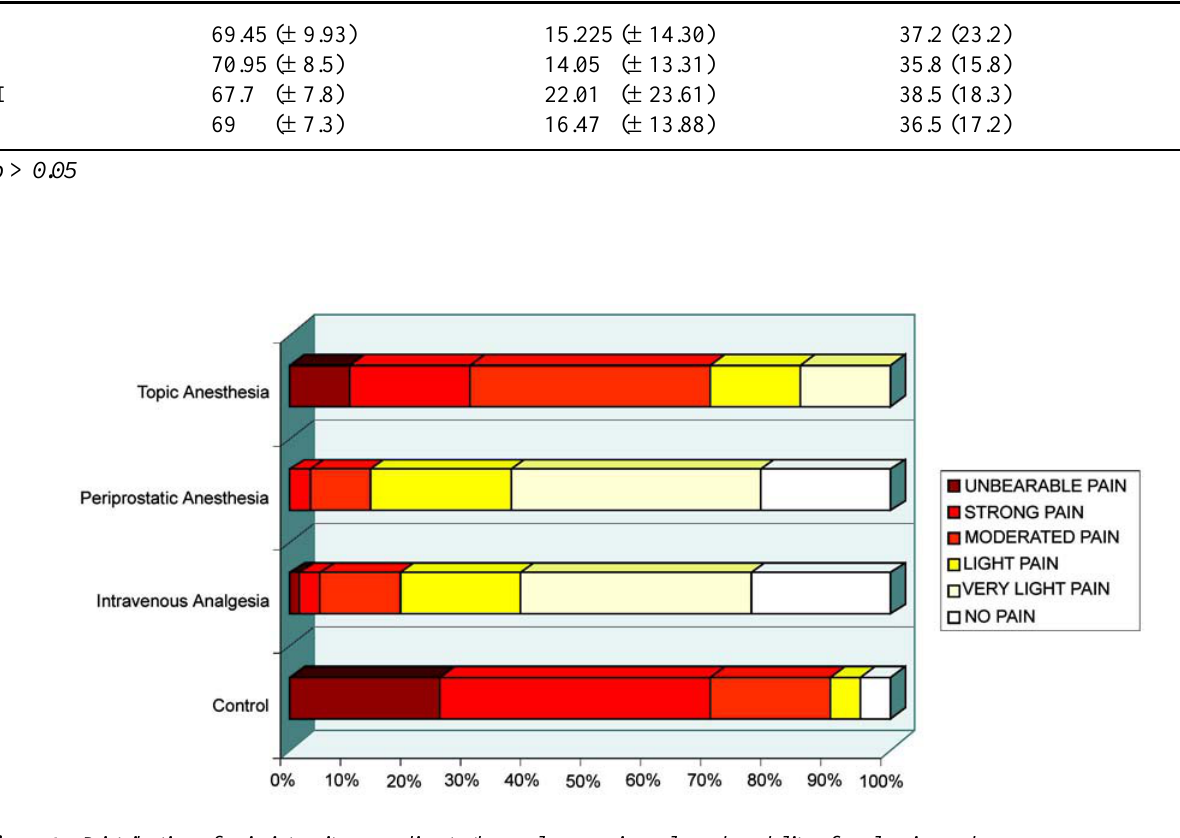
Figure 1 – Distribution of pain intensity according to the analogue pain scale and modality of analgesia